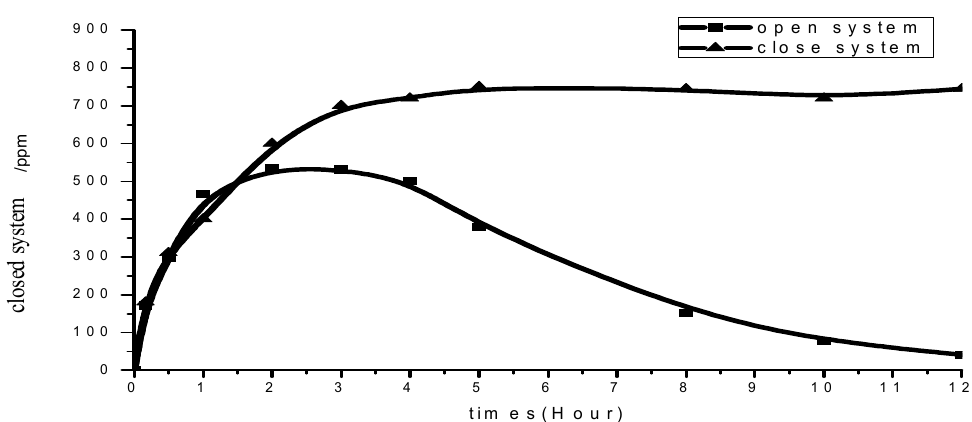
Figure 8. The essential oil released from microcapsules of alginate/tea tree essential oil in opened and closed system.